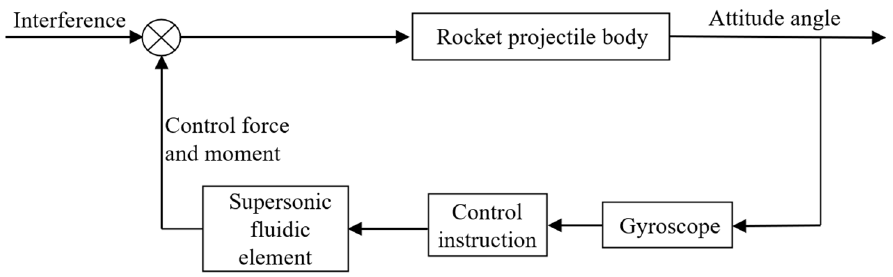
Figure 1. Working principle of the rocket attitude control system .